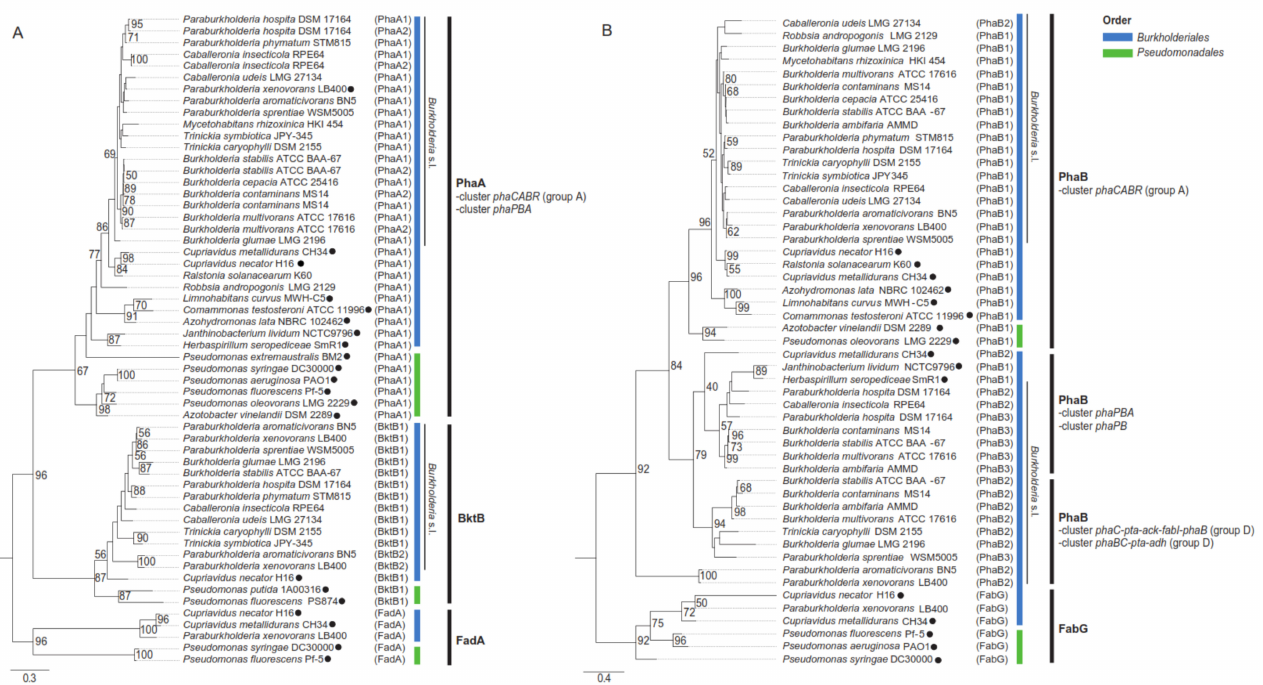
Figure 8. Phylogenetic trees of representative PhaA ( A ) and PhaB ( B ) amino acidic sequences of Burkholderia sensu lato (s.l.) strains. The phaC -related gene clusters from groups A and D of Burkholderia s.l. are shown. Search was carried out through the genomic context of PHA synthases and phasin encoding genes using Refseq and KEGG databases. Organisms of Burkholderiales (blue) and Pseudomonadales (green) orders, and sequences of BktB, FadA and FabG proteins are included as references ( • ). Phylogeny was reconstructed using an iterative multiple sequence alignment (Mafft software), maximum- likelihood algorithm with the LG+G+F substitution model with 1000 bootstrap replicates (RaXML software) and rooted according to minimal ancestral deviation method (MAD